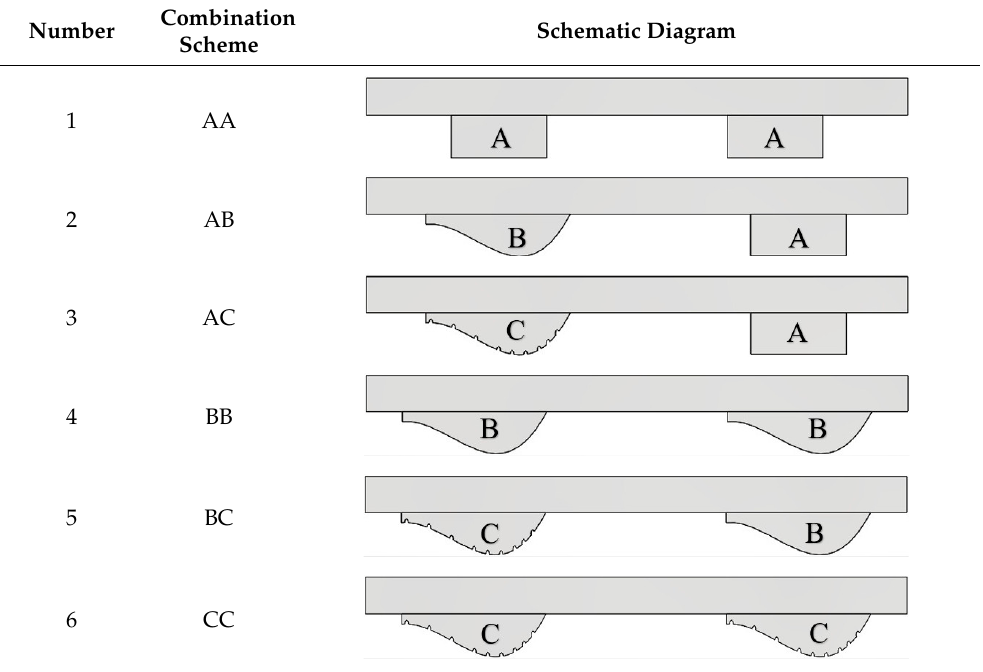
Table 2. Combination scheme of track shoe pattern.